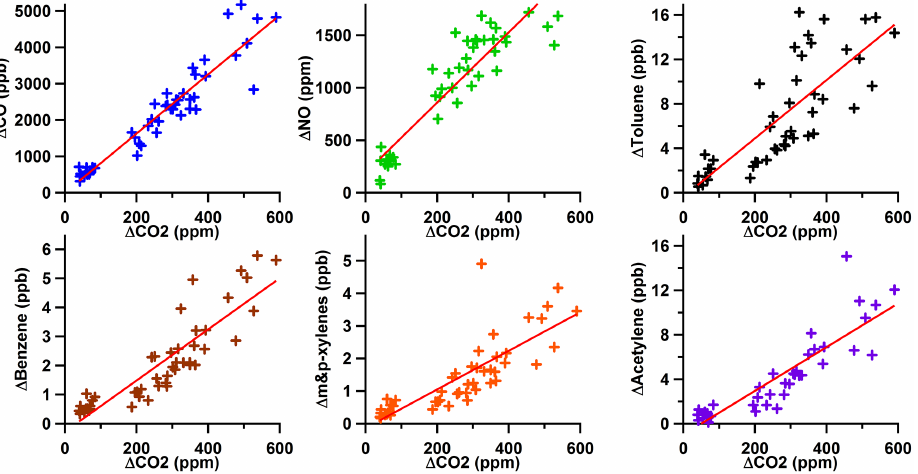
Figure 2. Correlations between (cid:49) CO 2 and selected co-emitted species. The red line represents the linear regression fit between (cid:49) CO 2 and the considered species. The linear regression does not intercept the (0, 0) point because of the uncertainty on the background level.